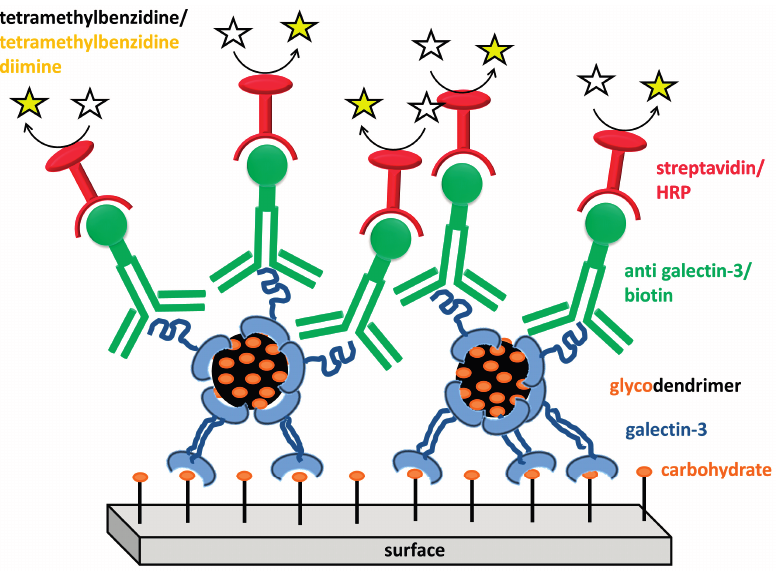
Figure 2. Multivalent complex formed with galectin-3 upon the addition of glycodendrimer. Using a traditional ELISA format with a carbohydrate-functionalized surface, glycodendrimers were observed to recruit galectin-3 rather than inhibit surface binding, which resulted in high absorbance